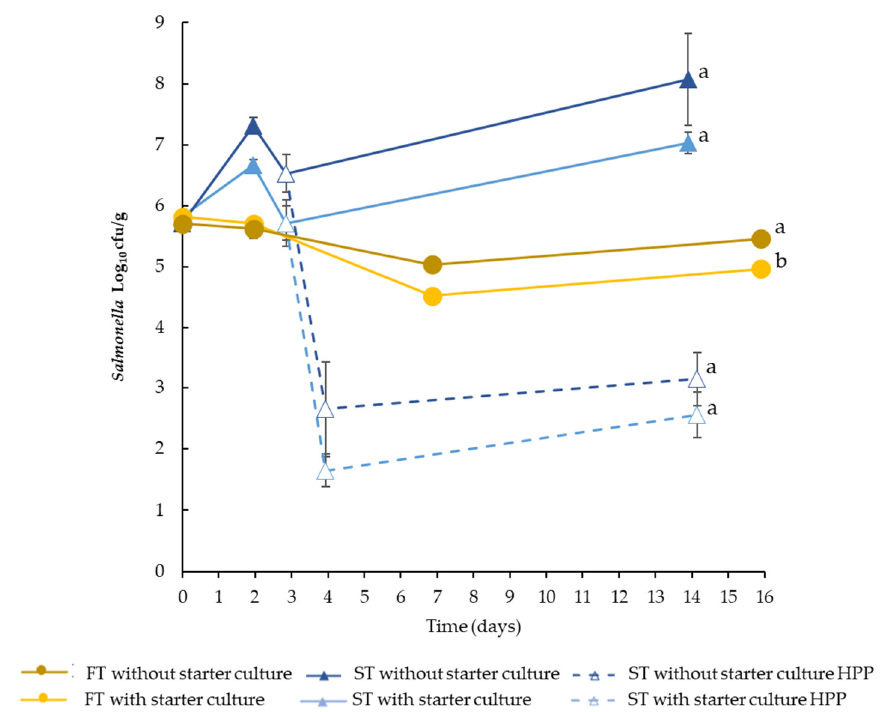
Figure 2. Counts (Log 10 cfu/g) of Salmonella during the production process of fuet -type (FT) and snack-type (ST) without and with starter culture and/or HPP. Dashed lines represent HPP samples at day 3. Error bars: standard deviation of three replicates. For each type of product (without and with starter), values at the end of process with a different letter are significantly different ( p < 0.05).